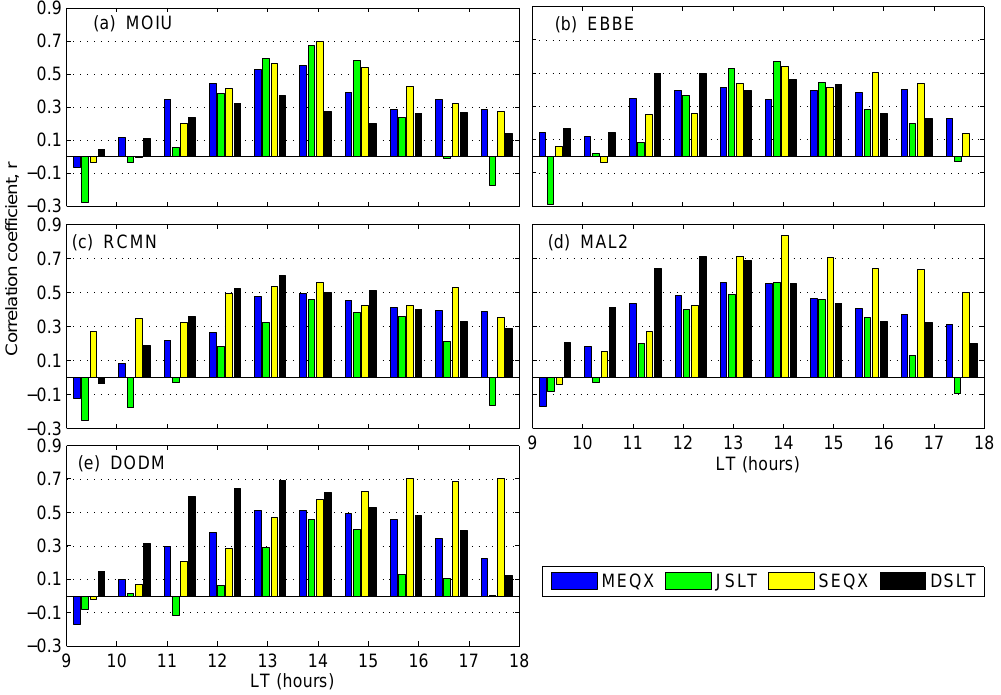
Figure 6. The LT variation of correlation coefficients between hourly EIA strength and daytime EEJ strength in MEQX (blue), JSLT (green), SEQX (yellow) and DSLT (black). Panels (a–e) are for correlation coefficients over MOIU, EBBE, RCMN, MAL2 and DODM, respectively.